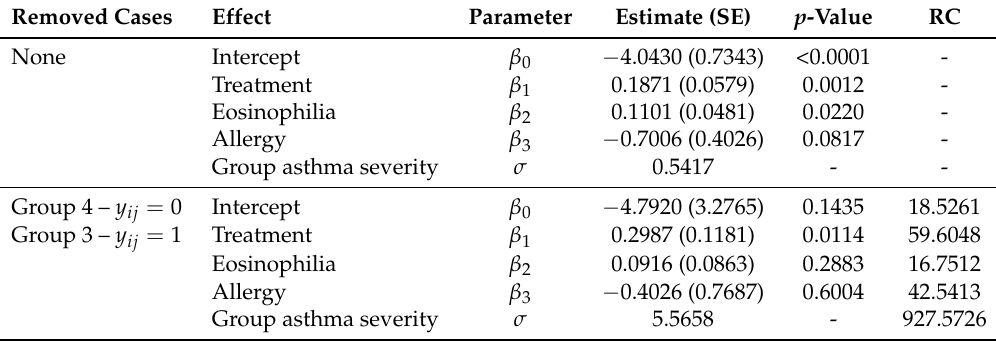
Table 10. Estimates (SE), p -values and RC under data-influence analytics for the asthma data.